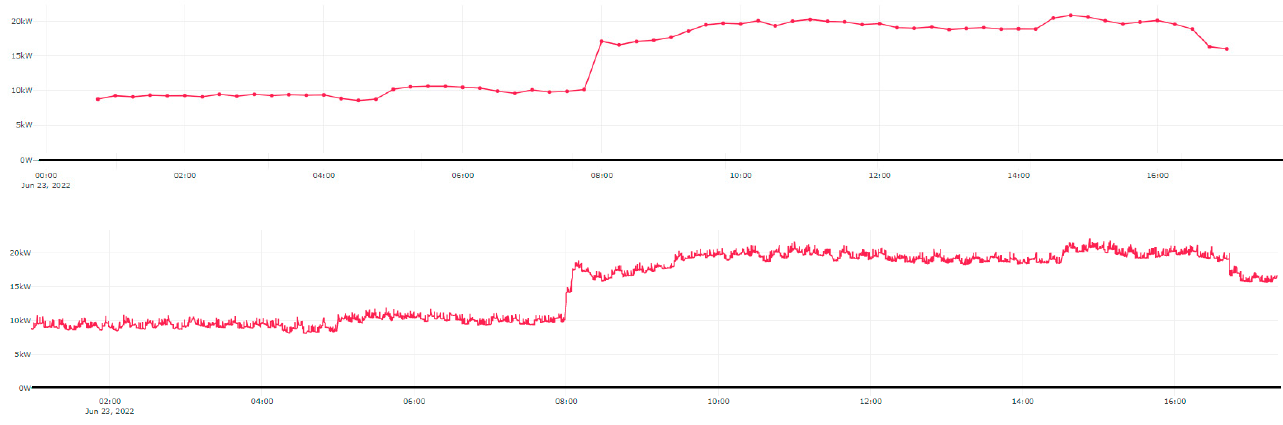
Figure 2. Comparison between a 15 min time step profile and a 5 s profile.